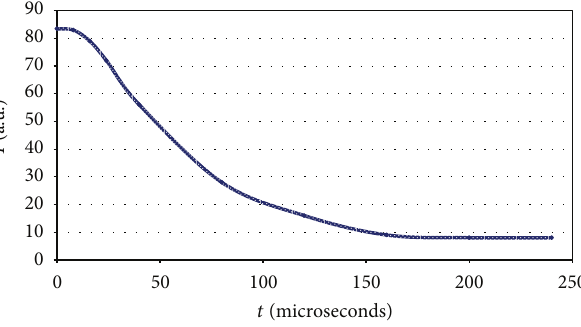
Figure 4: Switching process in NG film